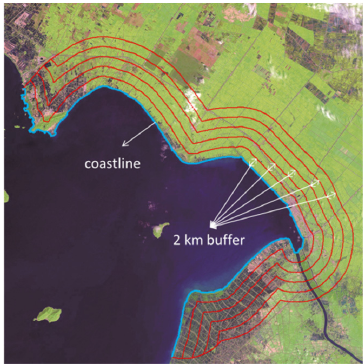
Figure 3. Segmentation buffers of R ạ ch Giá Bay.